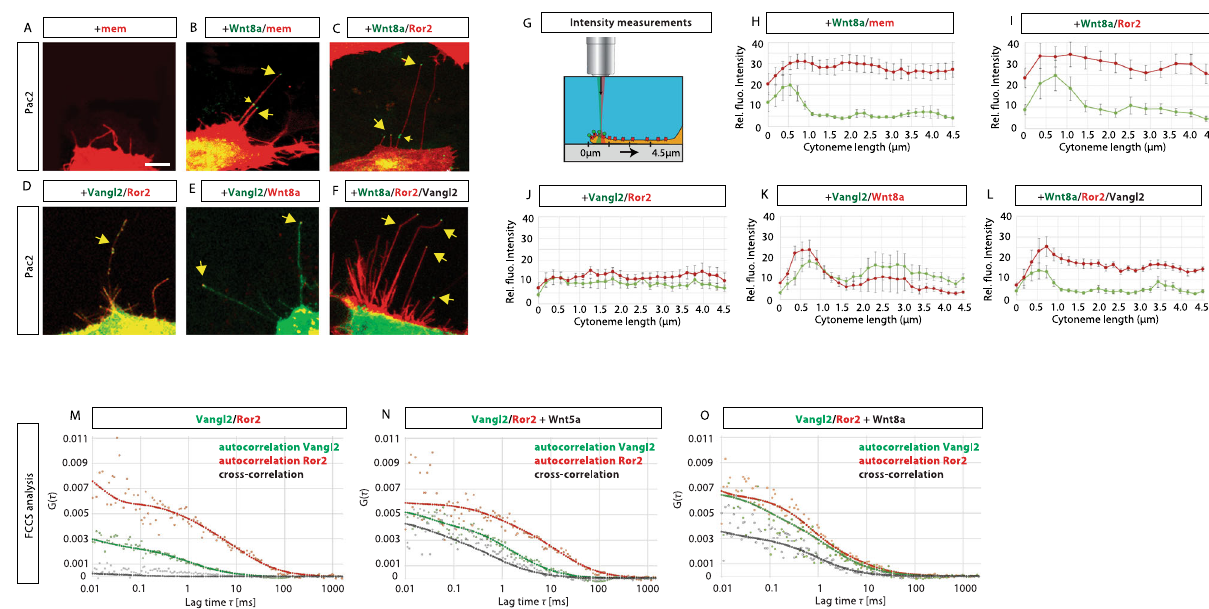
Fig. 1 Vangl2 is present on the tips of Wnt8a positive cytoneme. A – F PAC2 zebra fi sh fi broblasts transfected with indicated constructs and analysed live at 24 h of post-transfection. Yellow arrows indicate Wnt8a on tips of cytonemes. White scale bar equals 5 μ m. ( n = 25, 9, 14, 6, 25, and 14 cells). G Fluorescent intensity measurements were recorded ( H – L ) along cytoneme length as illustrated in G , from tip at 0 – 4.5 μ m along cytoneme. Cytonemes fl uorescent intensity measurements were taken up to 4.5 μ m from the cytoneme tip in each case. H – L Relative fl uorescent intensity analysis (gray value) of tagged proteins Wnt8a-GFP, Wnt8a-mCherry, Mem-mCherry, Ror2-mCherry, and GFP-Vangl2, relative pixel intensity values were measured along cytoneme length starting at the cytoneme tip, ( n = 17, 12, 12, 14, 11, and 12 fi lopodia). Standard error of the mean (SEM) = 1. M – O For the fl uorescence correlation spectroscopy (FCS) analysis, a focused laser spot was scanned across the membrane for 16s while the intensity was measured as a function of time ( G ( t )). Auto-correlation curve in red and green for Ror2 and Vangl2, respectively. Cross-correlation curve in gray. Fluorescent cross-correlation spectroscopy (FCCS) revealed cross-correlation of Ror2-mCherry and GFP-Vangl2 when exposed to Wnt5a protein or Wnt8a protein. ( n = 5 measurements/condition). CTRL D 2 (Ror2) = (37 ± 5) µ m 2 s − 1 , D 2 (Vangl2) = (23 ± 4) µ m 2 s − 1 , K D > 1100 nM; Wnt5a D 2 (Ror2) = (14 ± 3) µ m 2 s − 1 , D 2 (Vangl2) = (19 ± 5) µ m 2 s − 1 , K D = 173 nM; Wnt8a: D 2 (Ror2) = (11 ± 2) µ m 2 s − 1 , D 2 (Vangl2) = (16 ± 3) µ m 2 s − 1 , K D = 138 nM. Source data are provided